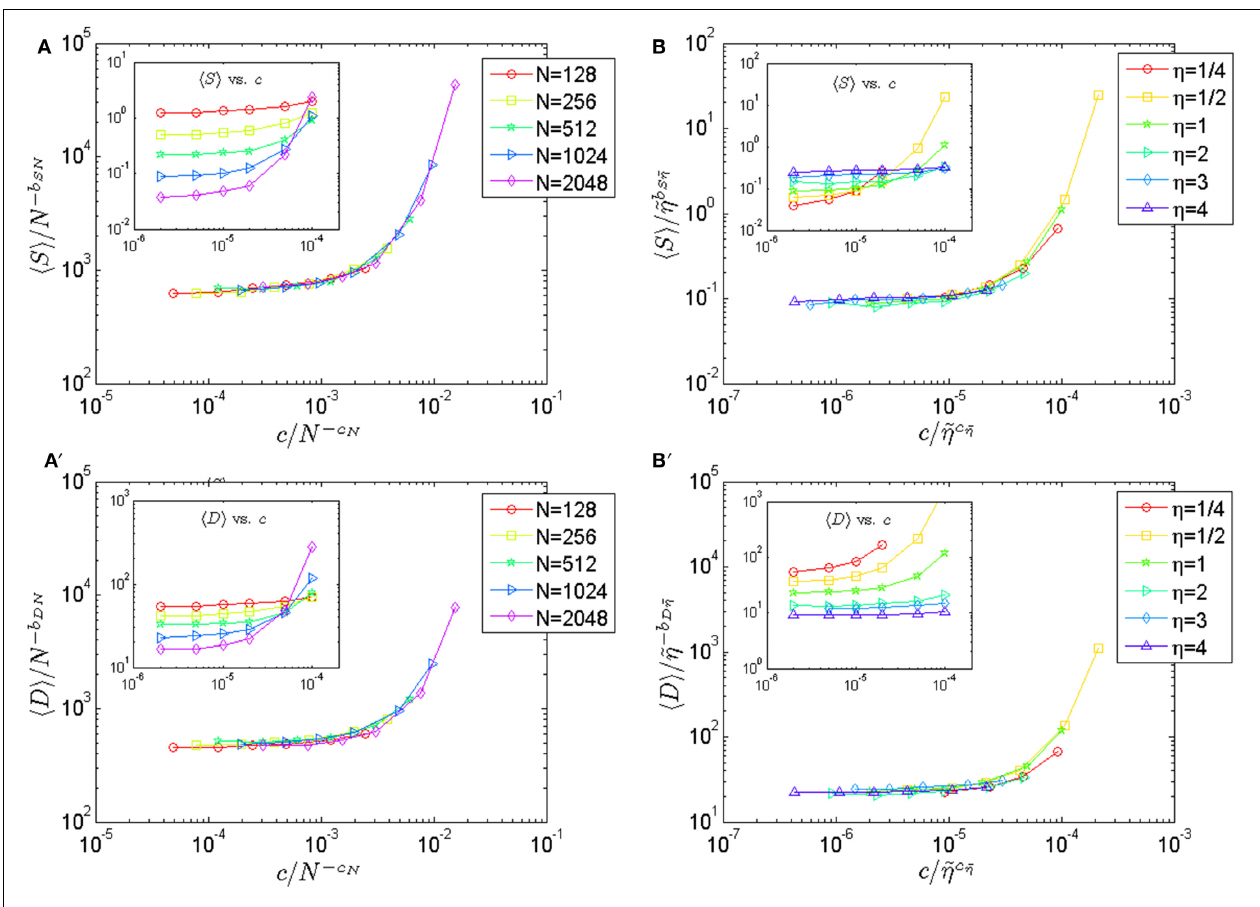
N = 1024. In all cases, the axes are logarithmic. Main panels: Curve collapse obtained by plotting (cid:4) S (cid:5) / N − b SN vs c / N − c N (A) , (cid:4) S (cid:5) / ˜ η − b S ˜ η vs c / N − c ˜ η (B) , (cid:4) D (cid:5) / N − b DN vs c / N − c N (A (cid:6) ) , and (cid:4)